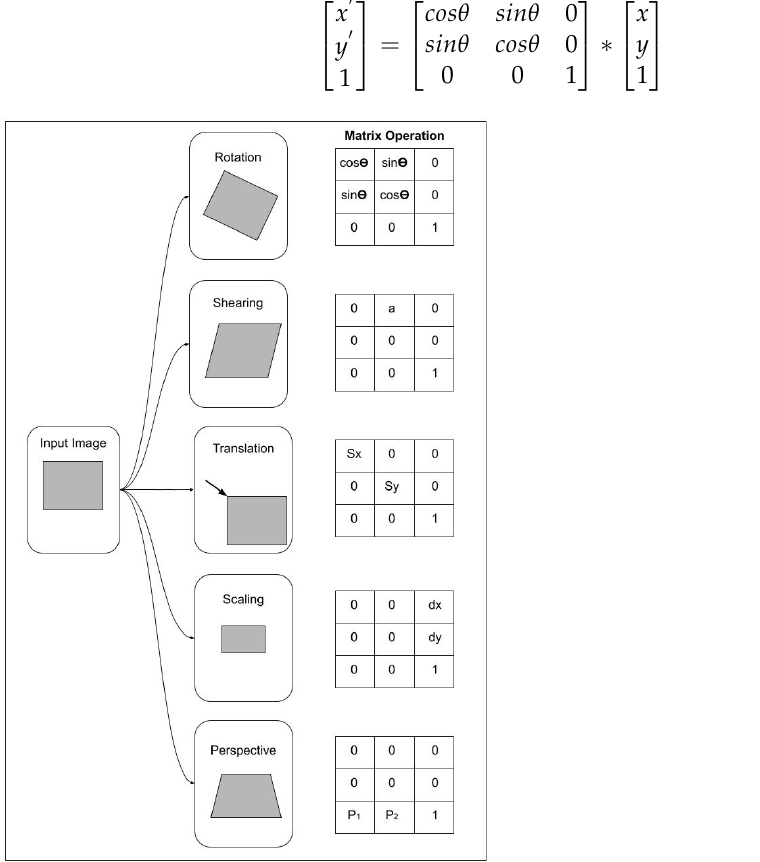
Figure 19. Affine and perspective